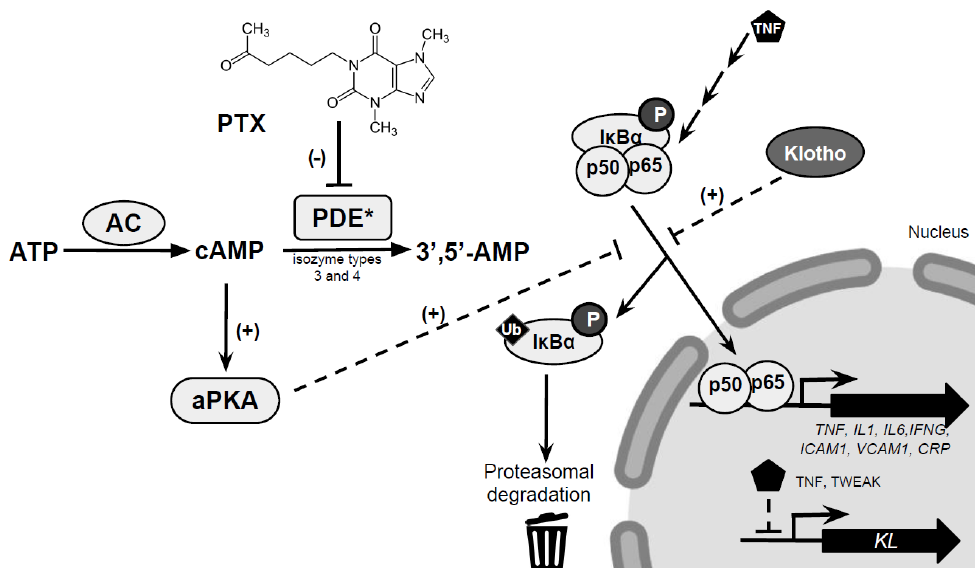
Figure 1. Suggested mechanisms of the anti-inflammatory effects of pentoxyfilline. Pentoxyfilline inhibits PDE activity increasing cAMP levels that activates PKA. Active PKA would inhibit ubiquitination that drives I κ B α to 26S proteasome degradation and p50/p65 activation of the expression of citokynes and other genes. Decreased levels of TNF and TWEAK increases KL expression, whereas KL inhibits the production of pro-inflammatory cytokines and TNF-induced adhesion molecules. PTX; pentoxyfilline; PDE, phosphodiesterase; ATP, adenosine triphosphate; AC, adenylate cyclase; cAMP, cyclic adenosine-3,5-monophosphate; aPKA, active protein kinase A; I κ B α , inhibitor of kappa B α ; p50 (NF- κ B1), nuclear factor NF-kappa-B p50 subunit (nuclear factor kappa-light-chain-enhancer of activated B cells 1); p65 (RelA), nuclear factor NF-kappa-B p65 subunit (V-Rel Avian Reticuloendotheliosis Viral Oncogene Homolog A); TNF, tumor necrosis factor α ; IL, interleukin; IFNG, interferon gamma; ICAM1, intercellular adhesion molecule 1; VCAM1, vascular cell adhesion molecule 1; CRP, C reactive protein; TWEAK, TNF-related weak inducer of apoptosis; KL, Klotho.